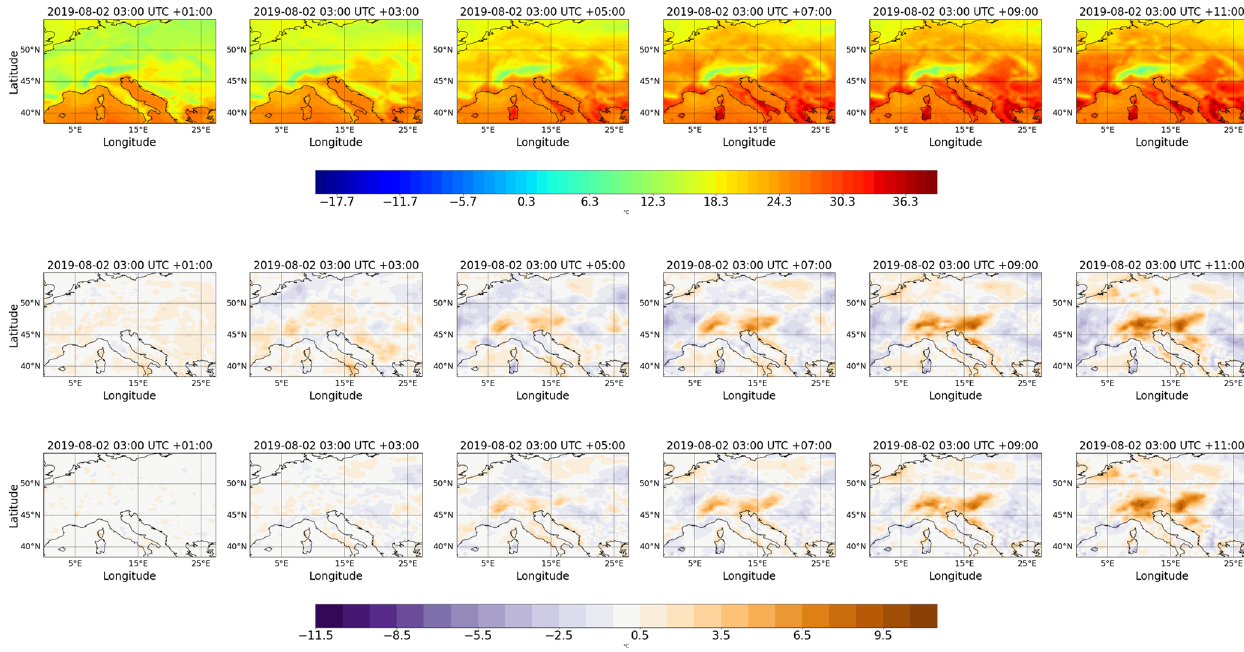
Figure C6. Analogous to Fig. 6 but for additional lead times (1, 3, 5, 7, 9, and 11h).